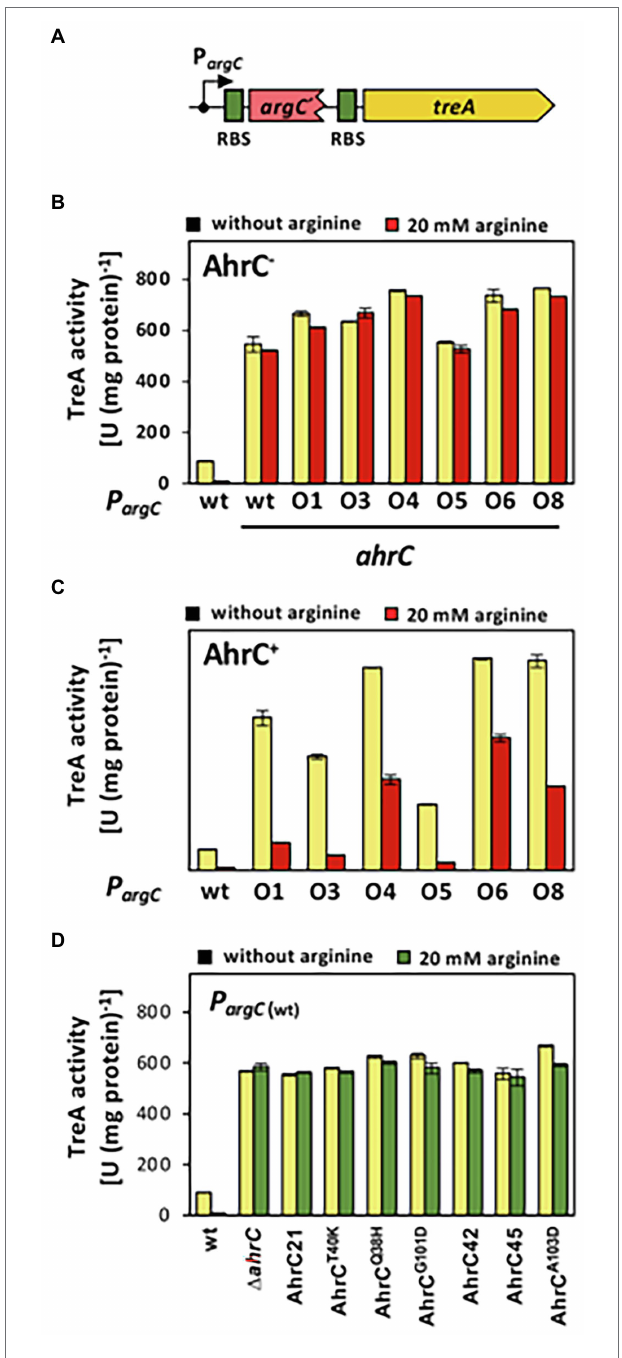
FIGURE 4 | Reporter gene assays assessing the influence of argC operator or ahrC regulator mutations on argC promoter activity. (A) Scheme of a P argC-treA transcriptional reporter fusion. The treA gene encodes a salt- tolerant a phospho- α -(1,1)-glucosidase (Schöck et al., 1996). In the reporter fusion construct, treA lacks its own promoter and its transcription is thus dependent on the promoter activity mediating the expression of the argCJBD- carAB-argF operon. treA possesses its own ribosome binding site (RBS; green box). (B, C) The P argC-treA transcriptional fusion was stably integrated via a double recombination event as a single copy into the chromosomal amyE gene of an ahrC mutant (B) , or into the chromosome of the ahrC +